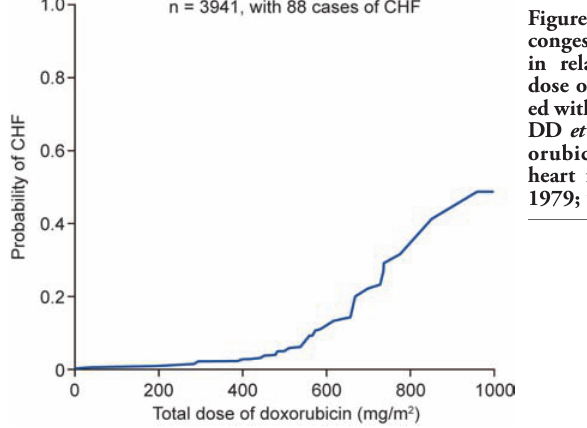
Figure 1. Overall survival of patients with non-Hodgkin’s lymphoma receiving three dif- ferent treatment regimens (3- year estimates of survival). 4 CHOP – cyclophosphamide, doxorubicin, vincristine, pred- nisone; m-BACOD – methotre - xate with leucovorin rescue, bleomycin, doxorubicin, cyclo - phosphamide, vincristine, and dexamethasone; ProMACE- CytaBOM – prednisone, dox- orubicin, cyclophosphamide, etoposide, followed by cytara- bine, bleomycin, vincristine, methotrexate with leucovorin rescue; MACOP-B – methotrex- ate with leucovorin rescue, doxo - rubicin, cyclophosphamide, vin - cristine, prednisone, and bleo - mycin. Reprinted with permis- sion from Fisher RI et al . Comparison of a standard regi- men (CHOP) with three inten- sive chemotherapy regimens for advanced non-Hodgkin’s lym-